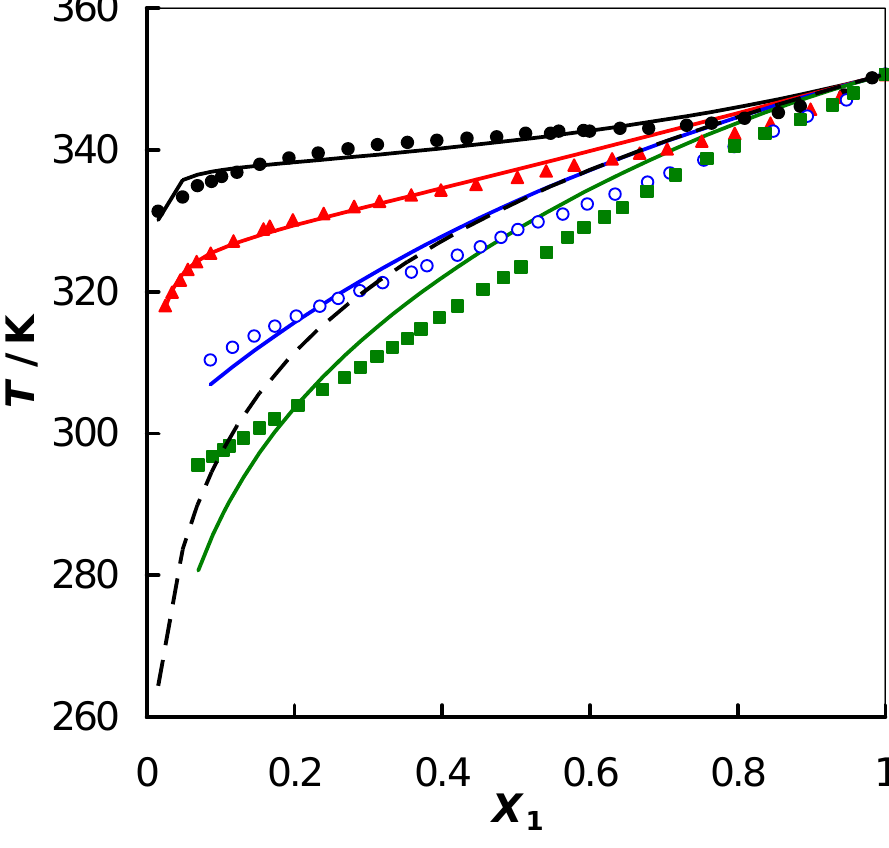
Figure 3. (Solid + liquid) phase equilibria of {[PMPYR][CF ( ● ) 1-decanol; ( ▲ ) 1-octanol; ( ○ ) 1-hexanol; ( ■ ) 1-butanol. Solid lines designated by the Wilson equation. Dotted line represents an ideal